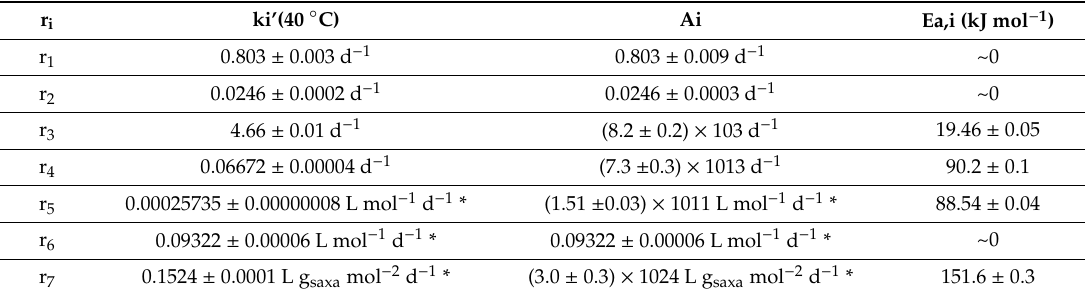
Figure 8. The concentration of saxagliptin (SAXA) degradation products (amidine (SCA), epimer (ESCA) and formyl-amide (SFA)) ( a – f ) reactions. Lines represent fitted model (m.), markers experimental data points (exp.). Tablet degradation tests were executed at the temperature of 30 ◦ C ( a – c ) or 50 ◦ C ( d – f ), the nominal water activity of 10% and the initial polyethylene glycol (PEG) to SAXA weight ratios of 0.8 ( a , d ), 1.0 ( b , e ), and 1.2 ( c , f ). The data for the measurements at 40 ◦ C, 10%, and 0.8–1.4 PEG to SAXA is presented in the Figure 6, respectively. A relative error of 10% is set based on sum of estimated analytical and sample variability. Table 4. The reaction (r i ) rate constants (ki’) at 40 ◦ C, pre-exponential factors (Ai) and activation energies (Ea,i) for tablet degradation tests, executed at the temperatures of 30 to 50 ◦ C, the nominal water activities of 10% to 50%, and the initial polyethylene glycol (PEG) to saxagliptin (SAXA) weight ratios of 0.8 to 1.4.